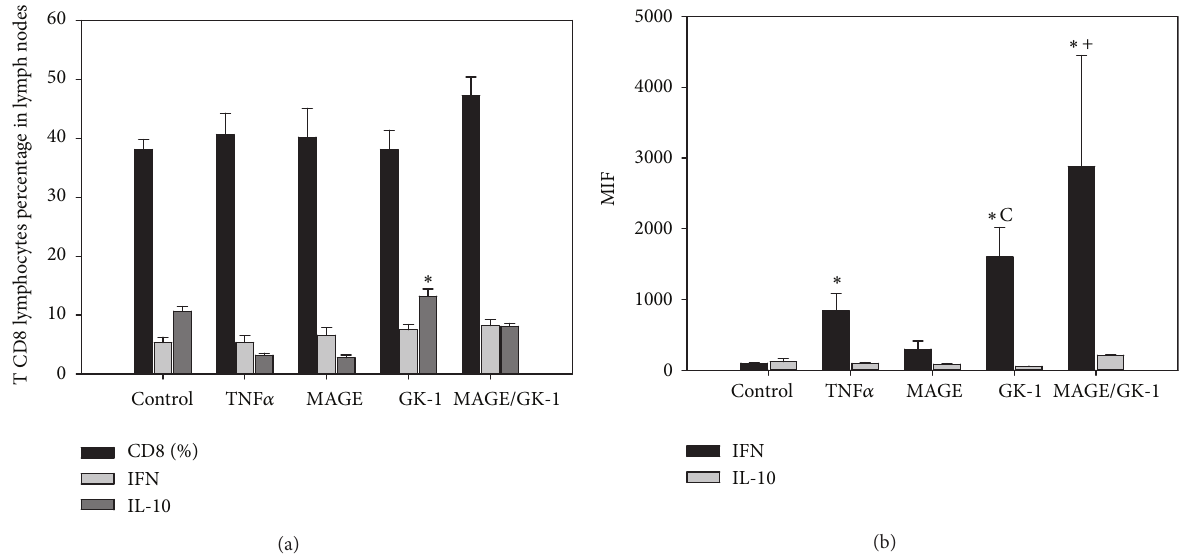
Figure 5: Cytokine profile. Percentage of total CD8 T cells and IFN 𝛾 or IL-10 producing CD8 cells, in peritumoral lymph nodes of mice with melanoma inoculated with BMDCs matured with TNF 𝛼 and treated with MAGE-AX, GK-1, or MAGE-AX/GK-1. Mice treated with BMDCs MAGE/GK-1 showed increased levels of IFN 𝛾 in CD8+ lymphocytes. (a) Percentage of total CD8 T cells and IFN 𝛾 and IL-10 producers. ∗ 𝑃 < 0.05 GK-1 versus all groups. (b) MFI of IFN 𝛾 and IL-10 in CD8 T lymphocytes. ∗ 𝑃 < 0.05 , c 𝑃 < 0.05 GK-1 versus MAGE, + 𝑃 < 0.05 MAGE/GK-1 versus MAGE. Without treatment (WT). Mean ± SEM 𝑛 ≥ 3